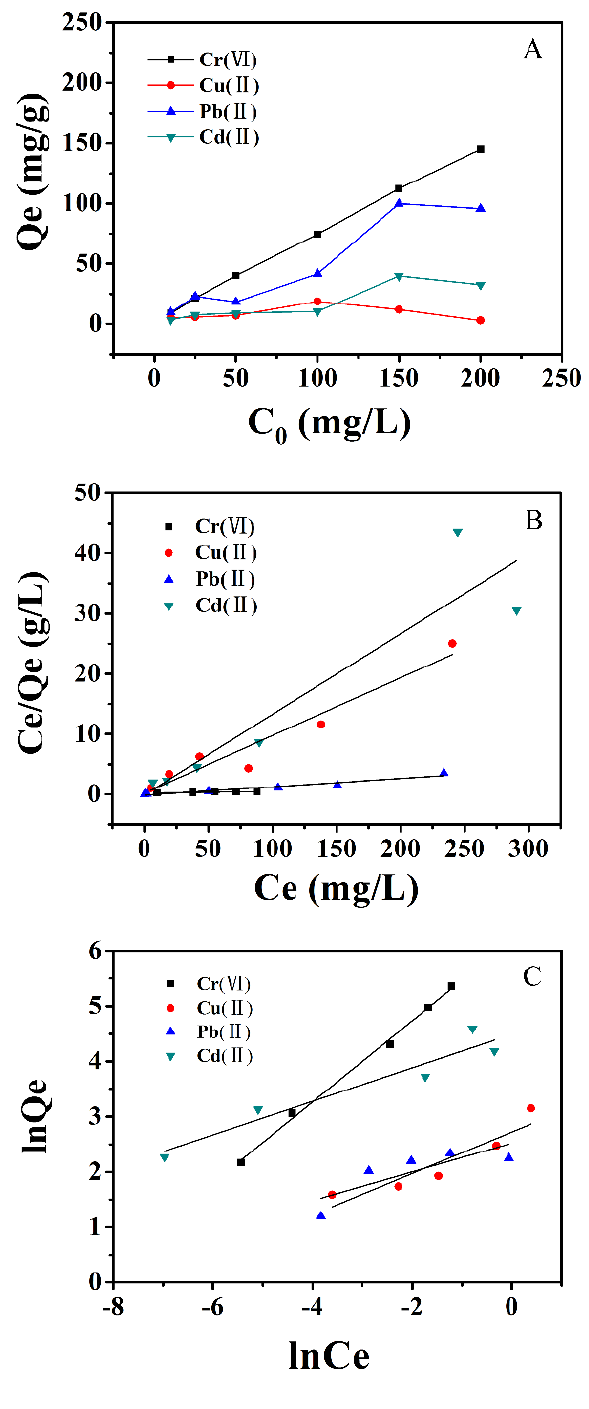
for metal ions; (B) 2 . [conditions: 2